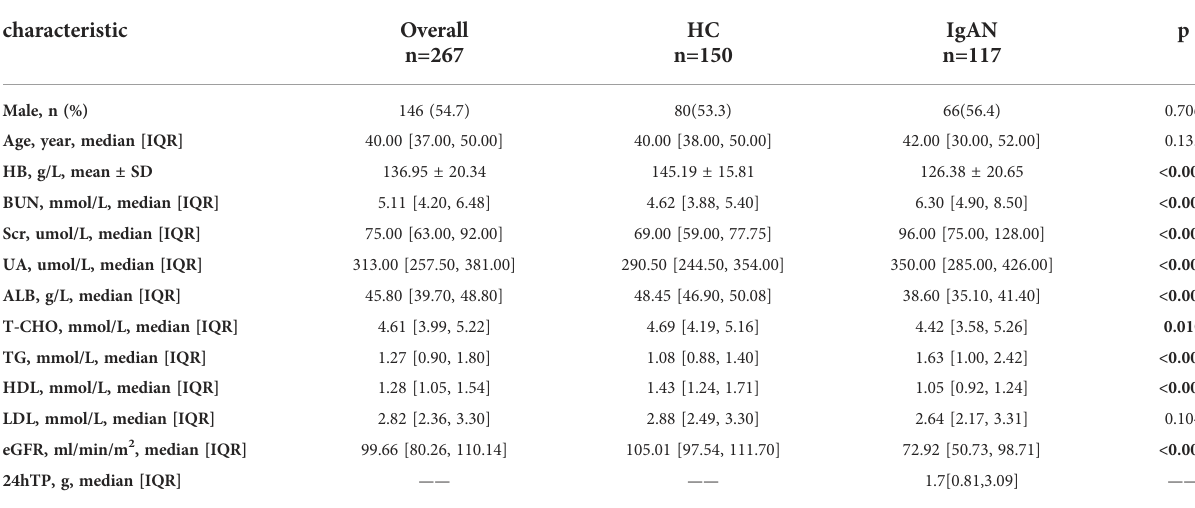
TABLE 1 Baseline characteristics of HC and IgAN.